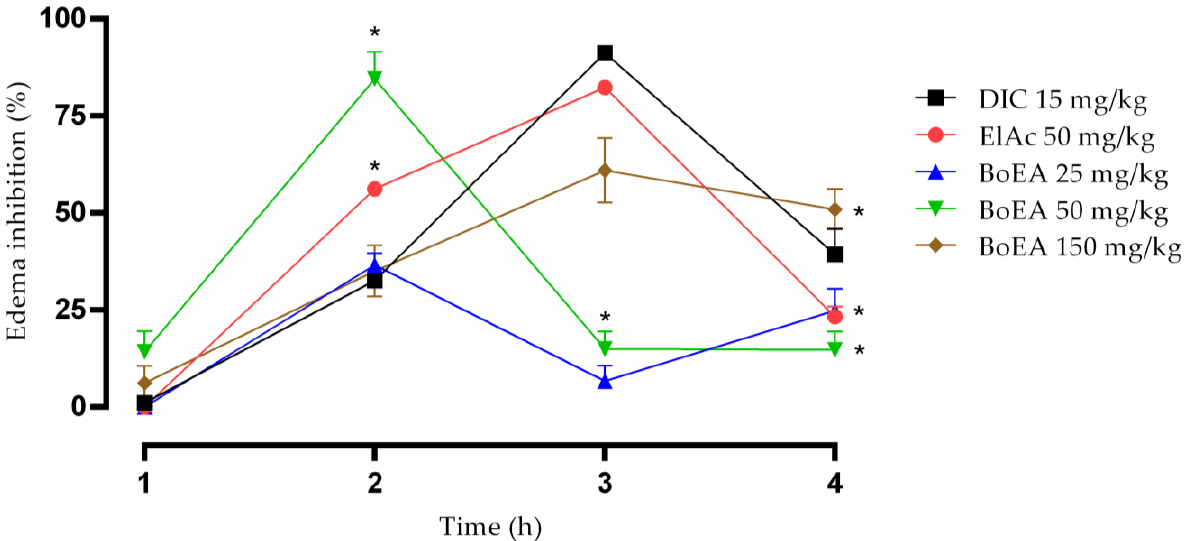
Figure 6. Anti-inflammatory effect of BoEA and ElAc in carrageenan-induced paw edema in mice. The thickness of the paw was measured 1, 2, 3, and 4 h after carrageenan injection. Data are presented as the mean ± SD. * p < 0.05 compared with the diclofenac-treated group. The results are representative of one of three independent experiments. Abbreviations: BoEA, ethyl acetate fraction of B. orellana ; ElAc, ellagic acid; DIC, diclofenac.